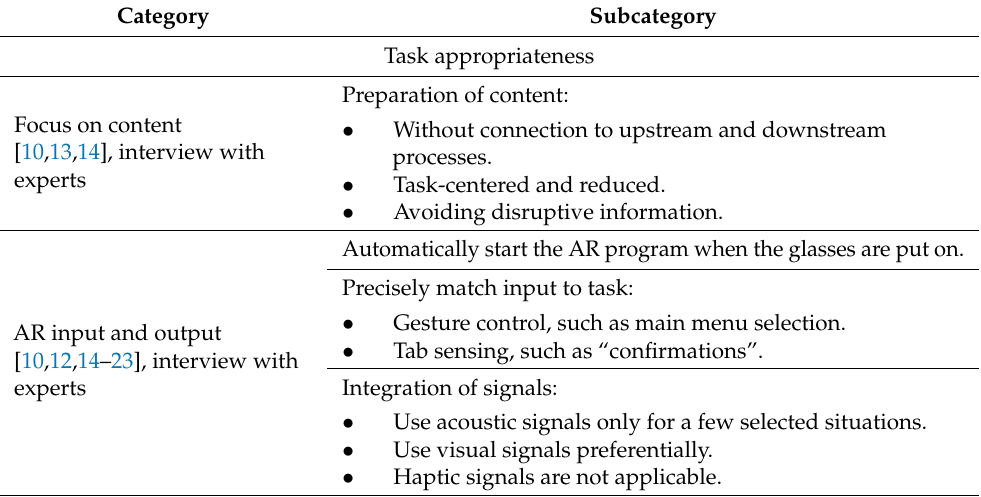
Table 2. AR system specific operationalization of the dialog principles according to DIN EN ISO 9241-110